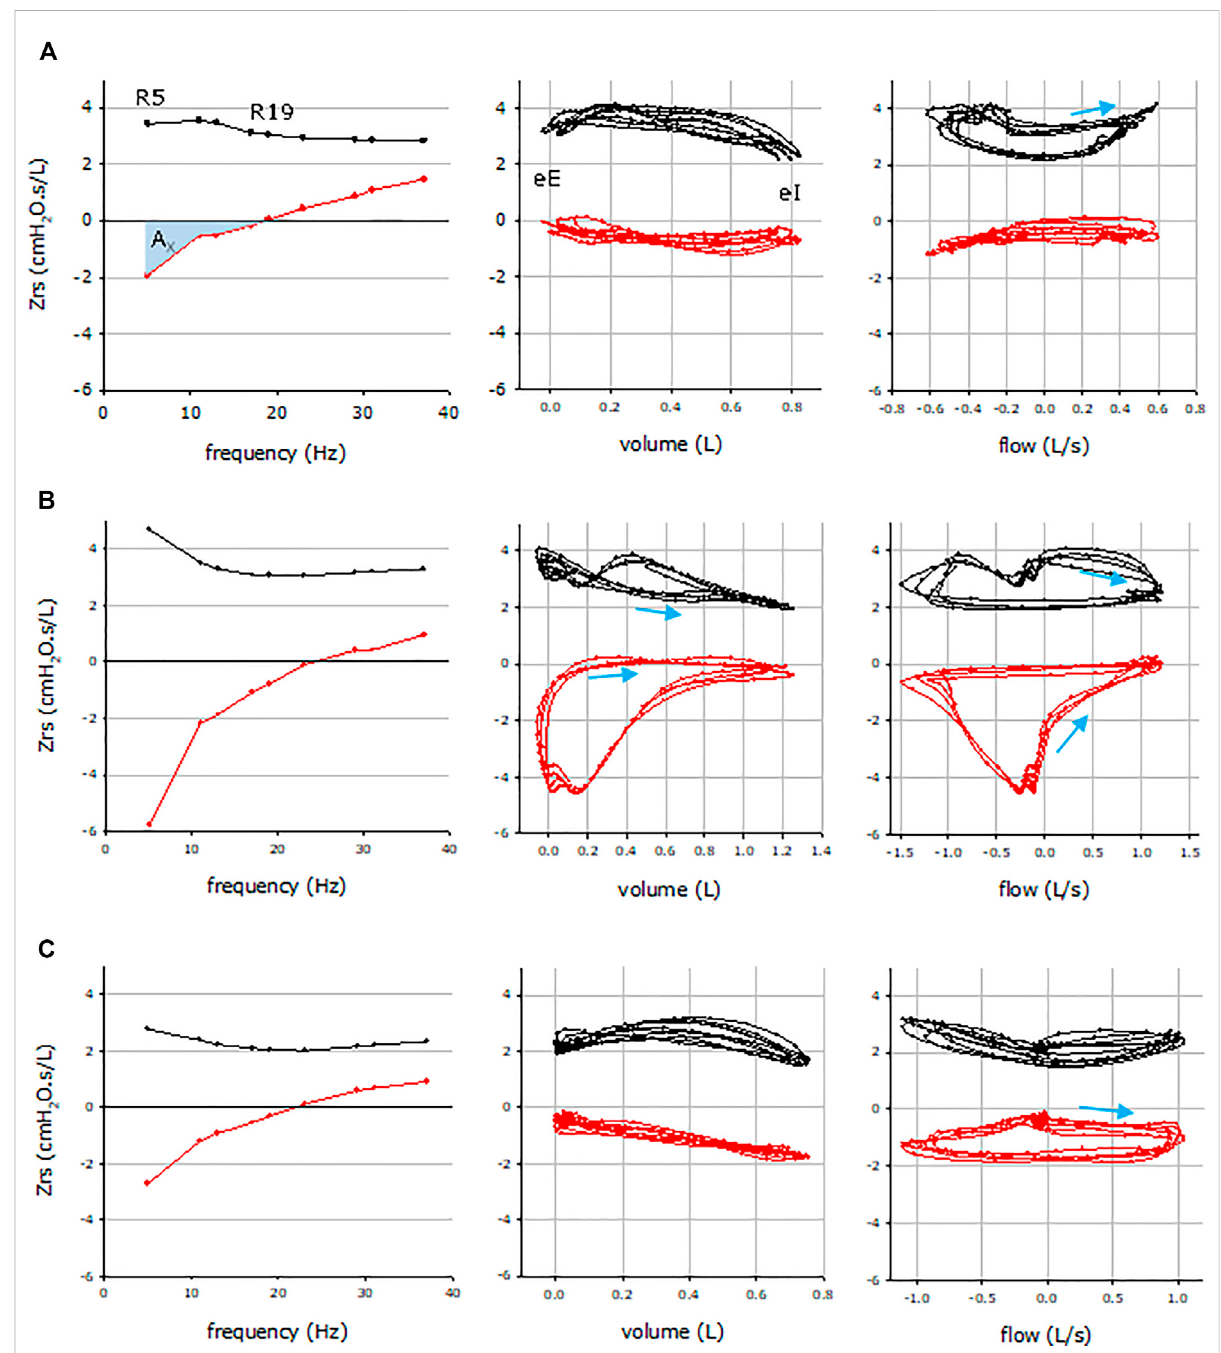
FIGURE 2 Representative respiratory impedance (Zrs) plots from a CLAD-free (A) , BOS (B) and RAS (C) subjects. Mean Zrs data vs. frequency (left), intrabreath Zrs data vs. volume (middle) and fl ow(right). Resistanceand reactancedata are plotted in black andred, respectively. Arrows indicate the inspiratory directions in the intrabreath loops, wherever the looping is signi fi cant. R5 and R19, resistance at 5 and 19 Hz, respectively; eE, end expiration; eI, end inspiration; AX, reactance area between 5 Hz and resonance